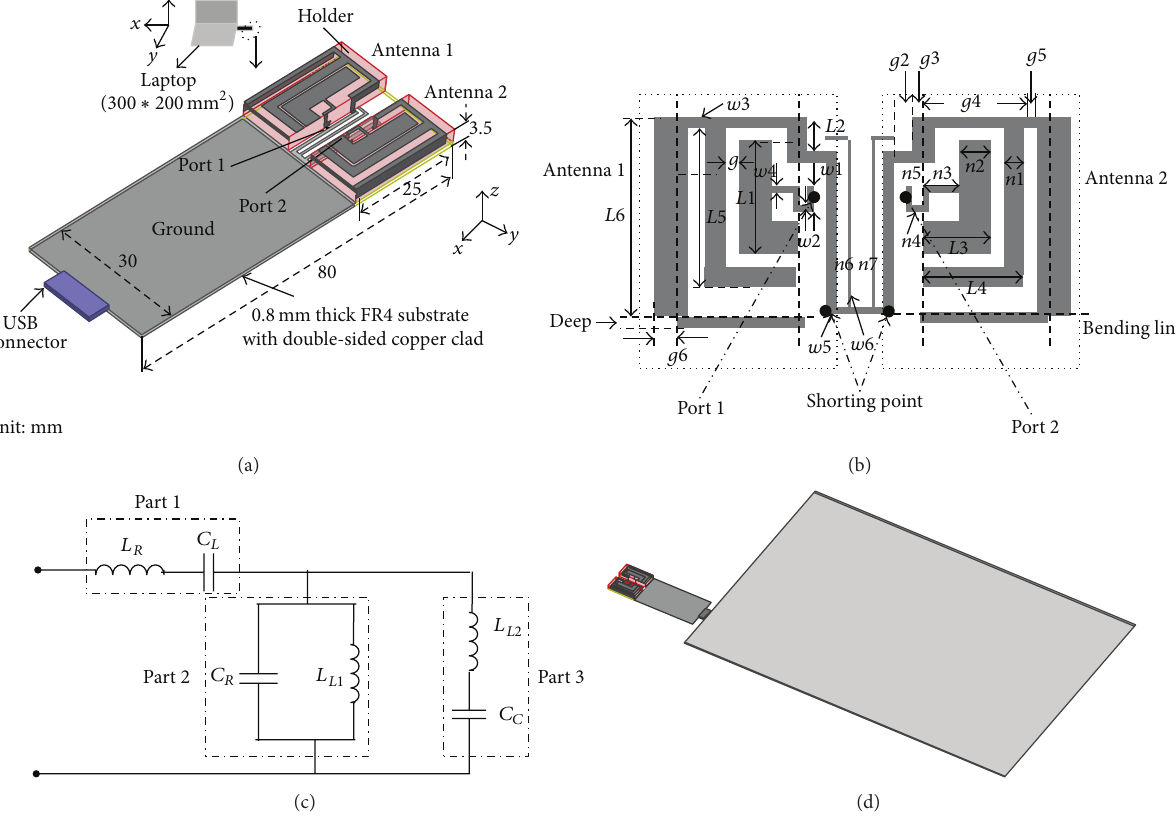
Figure 1: Geometry of the proposed multiband MIMO antenna system: (a) 3D view of the proposed MIMO antenna, (b) MIMO antenna and decoupling structure, (c) equivalent circuit of the unit antenna of the MIMO system, and (d) simulation model for the MIMO antenna system connected by the laptop.